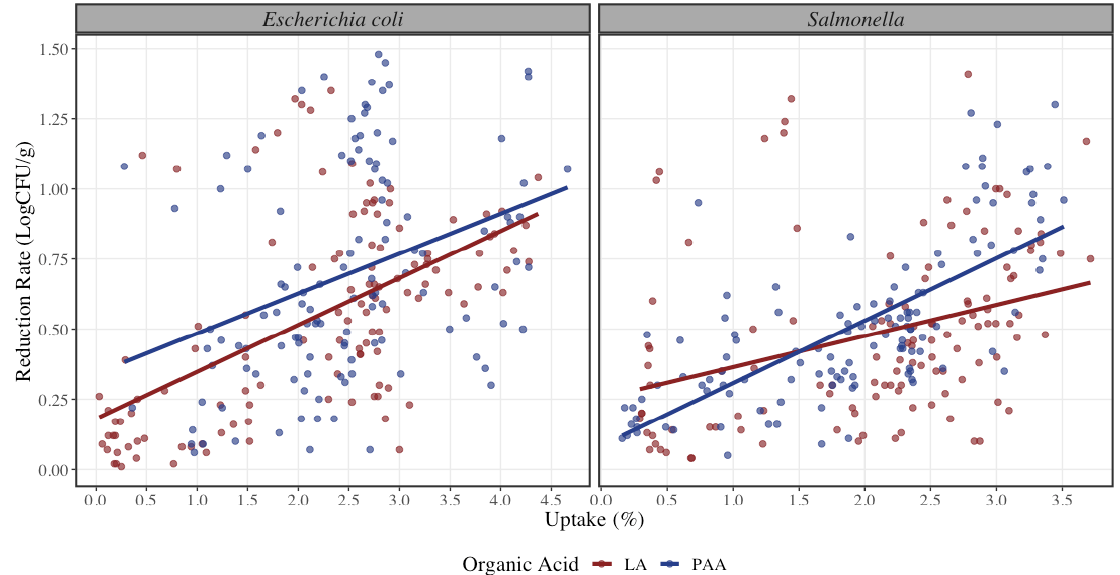
Figure 1. Reduction rate of Shiga-toxin producing Escherichia coli and Salmonella spp. at different